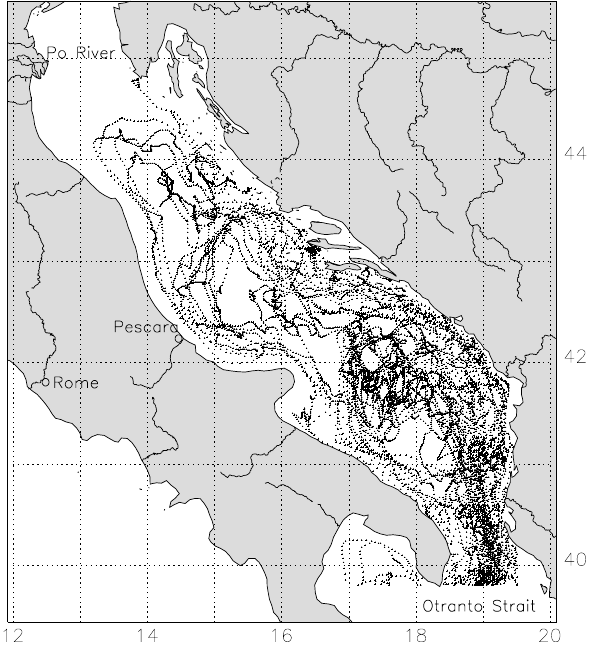
Fig. 1. Plot of the 37 drifter trajectories in the Adriatic Sea used for the data analysis. The longitude east and latitude north coordinates are in degrees. The drifters were deployed on the eastern side of the Otranto